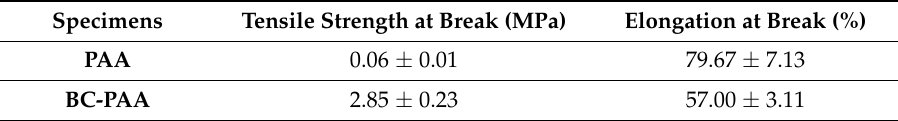
Figure 3. Mechanical properties of various BC-PAA composites. Table 1. Mechanical property comparisons of PAA and BC-PAA.